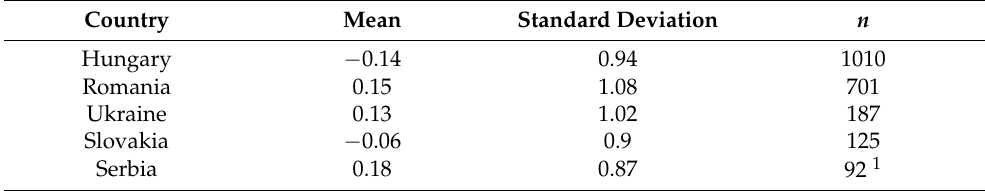
Table 3. Mean and standard deviation of the principal component of performance by country.